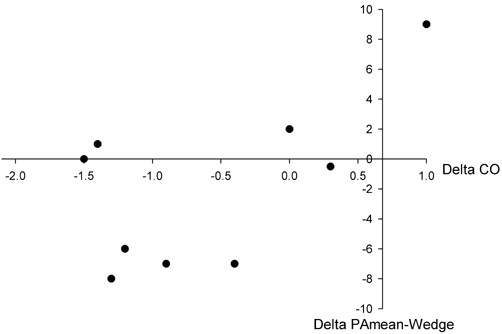
Dynamic pressure-flow plot. The effect of open lung ventilation (OLC) on flow and pressure drop through the pulmonary circulation is displayed compared with conventional mechanical ventilation (CMV). On the vertical axis, change of pressure drop through the pulmonary circulation is displayed: mean pulmonary artery pressure (PAmean)–pulmonary capillary wedge pressure during OLC – PAmean–pulmonary capillary wedge pressure during CMV. On the horizontal axis, the change of cardiac output (CO) is displayed.